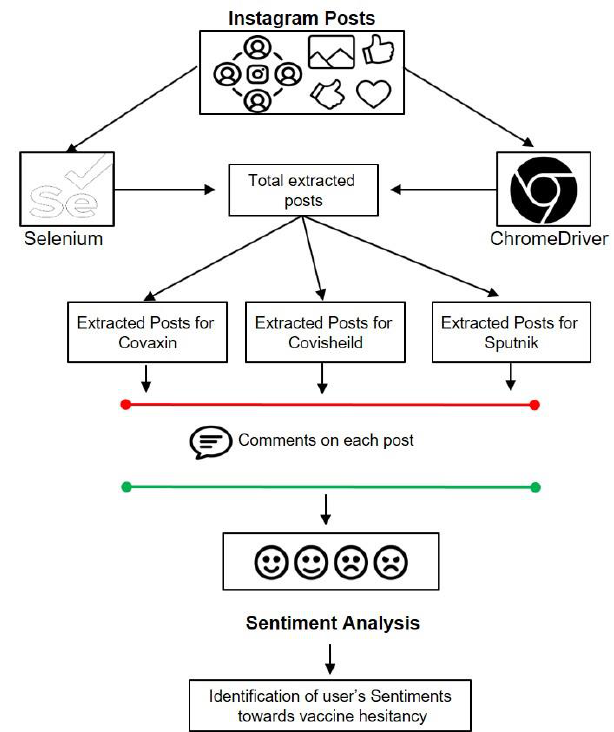
Figure 2. Block diagram for the sentiment analysis of posts and comments from Instagram.